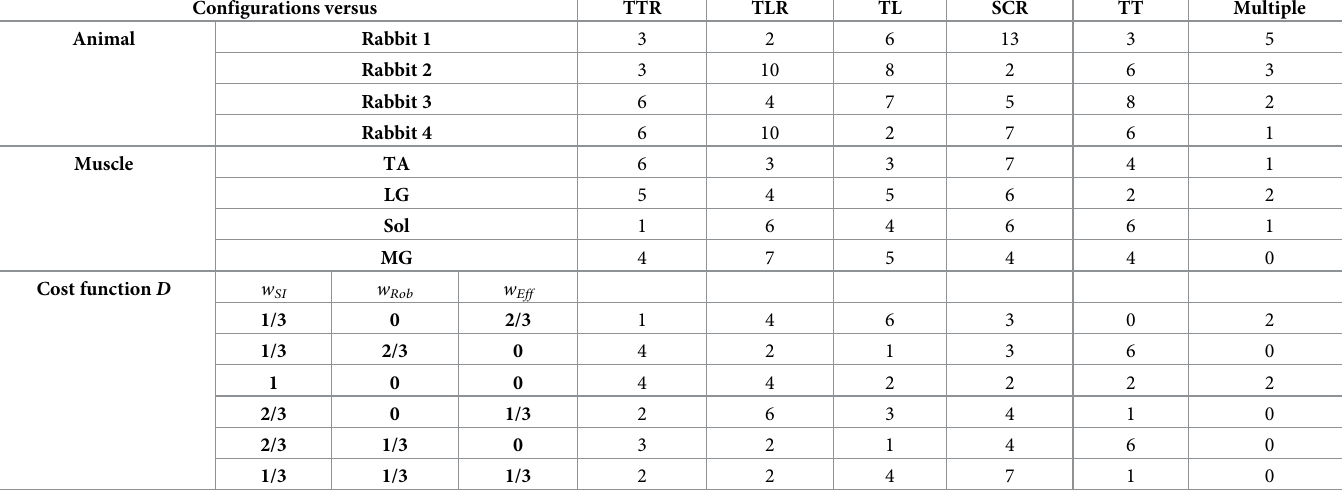
Table 5. Configuration occurrence as the optimal solution according to i) animal, ii) muscle, iii) weighted cost function D . “Multiple” means that more than one con- figuration was found to be optimal (equal cost function D ). Configurations versus